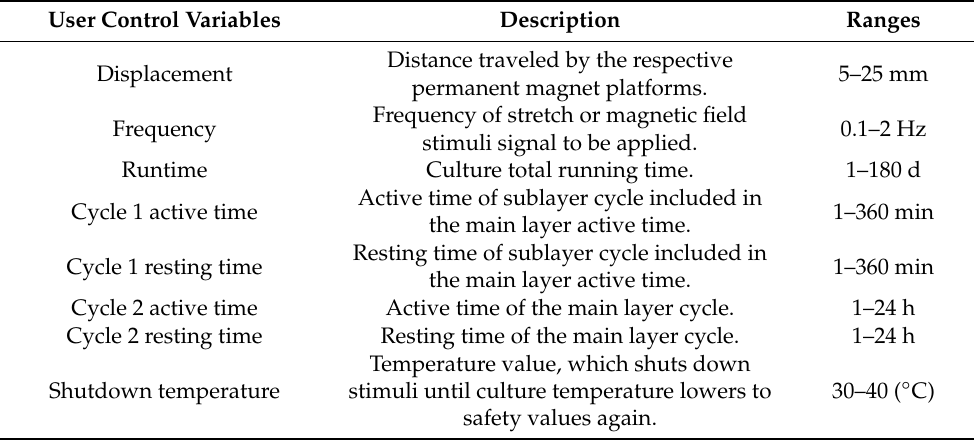
Table 1. Bioreactor user control variables and respective ranges to be set in the programs menu.